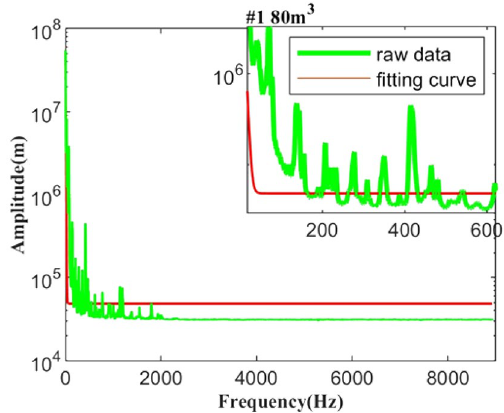
Fig. 3 #1 Spectrum fitting diagram